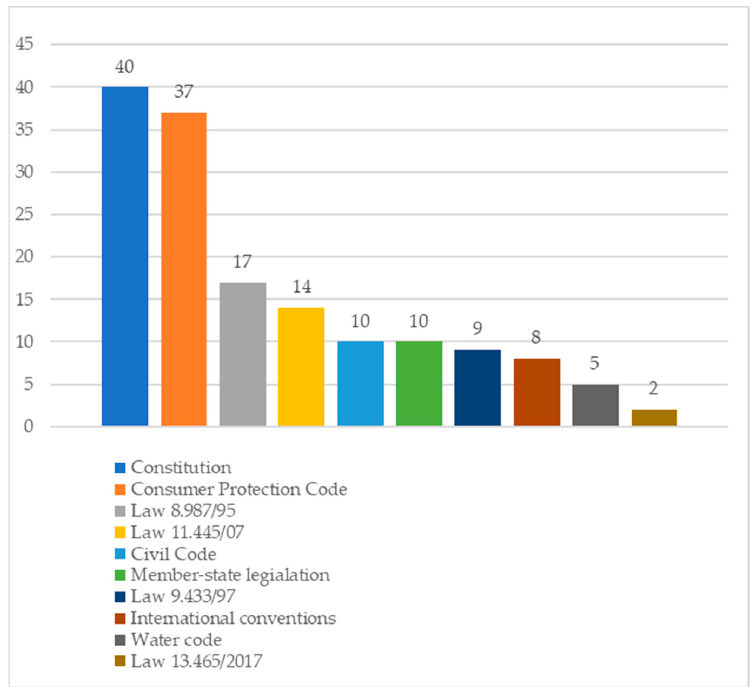
Figure 8. References to legal norms.